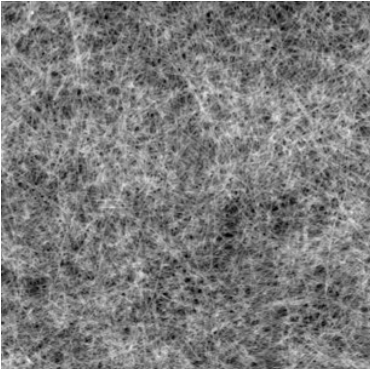
Figure 3. Atomic force microscopy (AFM) image (5 µ m × 5 µ m) of ADS P3HT film on SiO 2 / Si.